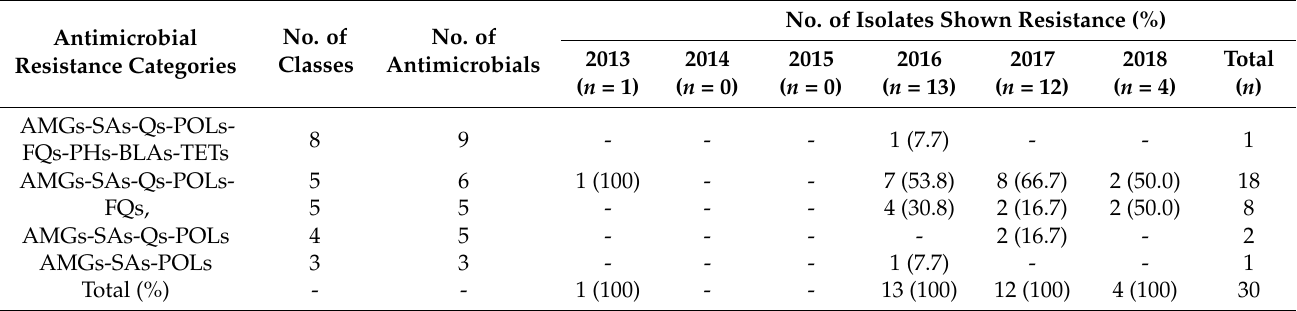
Table 3. Multi-drug resistance of S. enterica ser. Gallinarum isolates obtained from 2013 to 2018. Antimicrobial Resistance